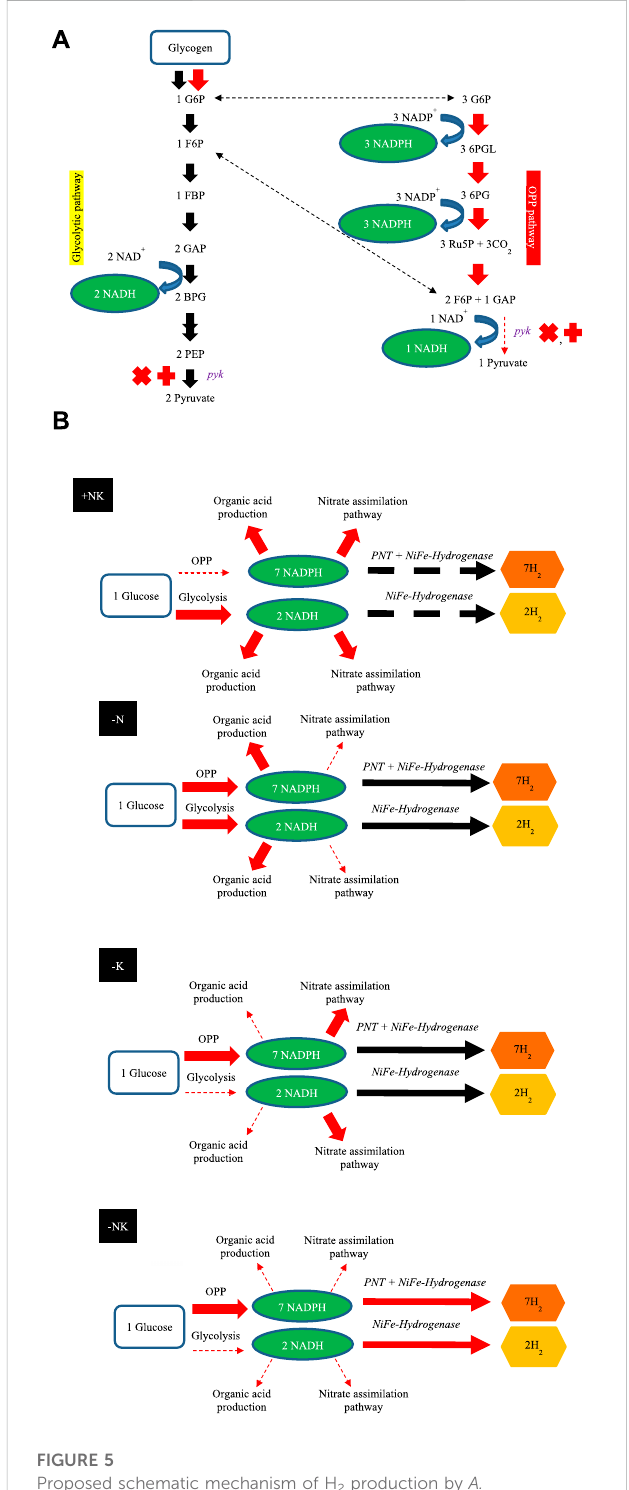
FIGURE 5 Proposed schematic mechanism of H 2 production by A. halophytica based on the RNA-seq after adaptation in nitrogen and/or potassium deprivation for 2 days. Glycolytic and OPP pathways are involved in NAD(P)H generation via glycogen catabolism (A) . Proposed H 2 metabolism and involved pathways of A. halophytica incubated in BG11 (+NK), BG11 0 (-N), BG11-K (-K), and BG11 0 -K (-NK) under dark anaerobic conditions (B) . Arrows show electron transport direction in each